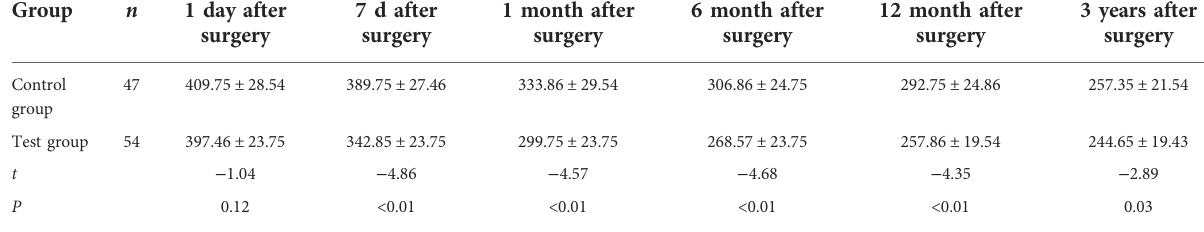
TABLE 2 Serum LDH levels at each time point after surgery in the two groups of patients ( (cid:1) x + s , U/L). Group